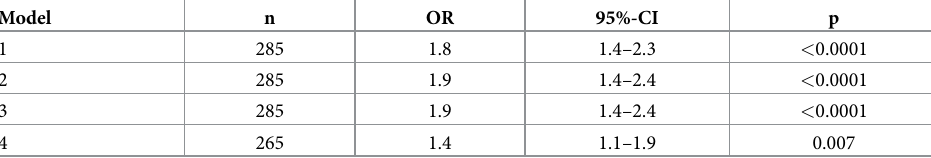
Table 1. Associations between day 0 plasma ACE2 and maximal acuity within 28 days in COVID-19 positive patients in ordered logistic regression models. Model